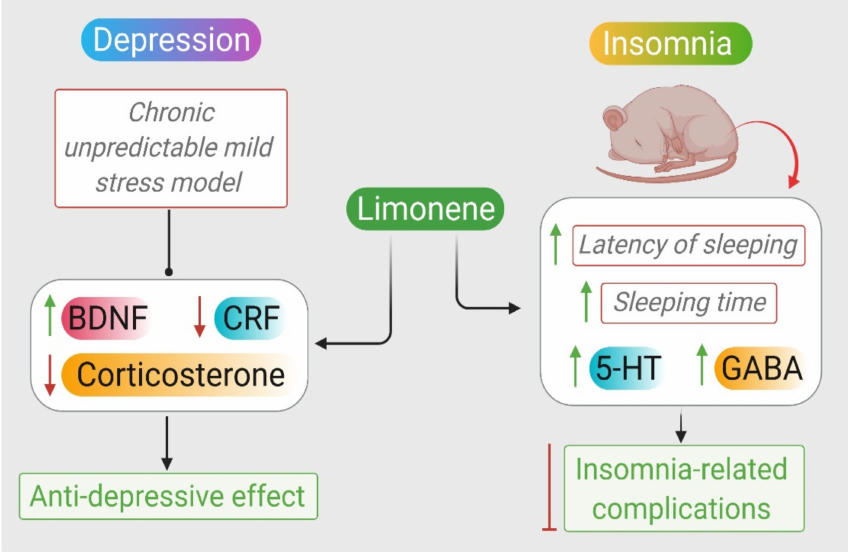
Figure 5. Neuroprotective mechanisms of limonene in depression and